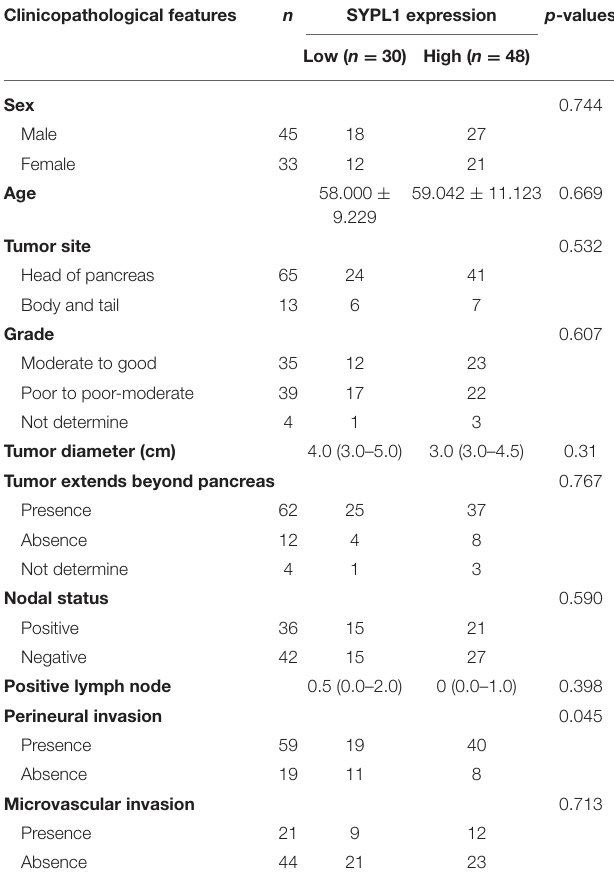
TABLE 1 | Characteristics of pancreatic ductal adenocarcinoma patients from Sun Yat-sen University Cancer Center. Clinicopathological